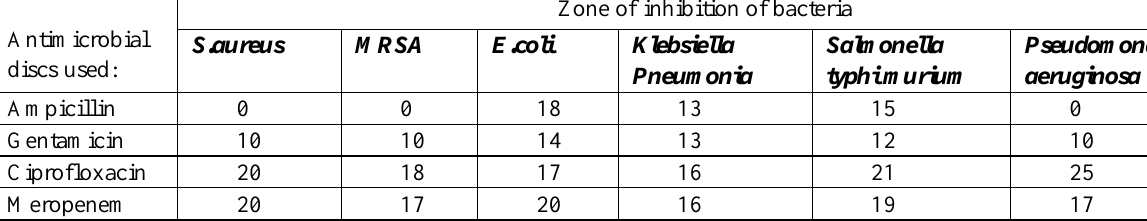
Zone of inhibition of bacteria